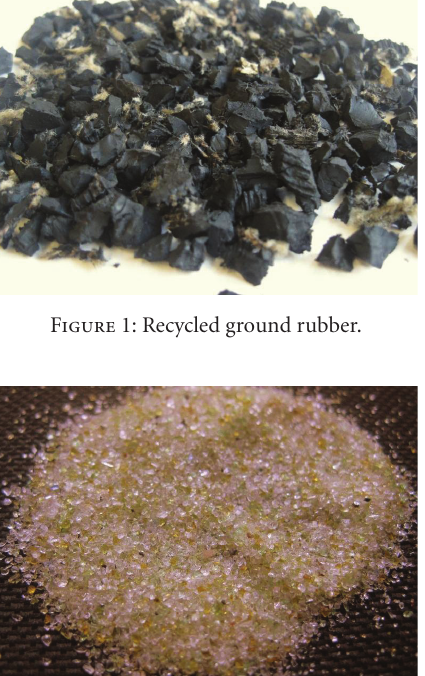
Figure 2: Recycled glass.